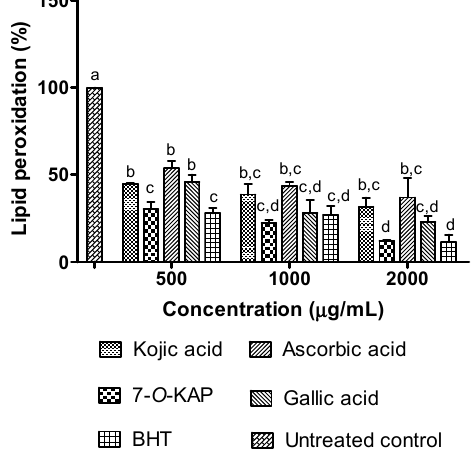
Figure 11. The standard curve of ferric ion antioxidant power (FRAP) was obtained using 0–350 μ g/mL of ascorbic acid at absorbance of 630 nm. Figure 10. Ferric ion antioxidant power (FRAP) of kojic acid and 7- O -kojic acid monopalmitate (7- O - Figure 11. The effect of kojic acid and 7- O -kojic acid monopalmitate (7- O -KAP), ascorbic acid, gallic KAP). Data are presented as means ± S.E.M, and expressed as number of gram equivalents of ascorbic acid and BHT on the activity of lipid peroxidation. The results are expressed as means ± S.E.M of acid per mL (AAE/mL), n = 3. The letters a and b indicate significant difference at p < 0.05 with percentage (%) to untreated control, n = 3. BHT was used as positive control. The letters a, b, c, and d Bonferroni’s Multiple Comparison Test. indicate significant difference at p < 0.05 with Bonferroni’s Multiple Comparison Test.